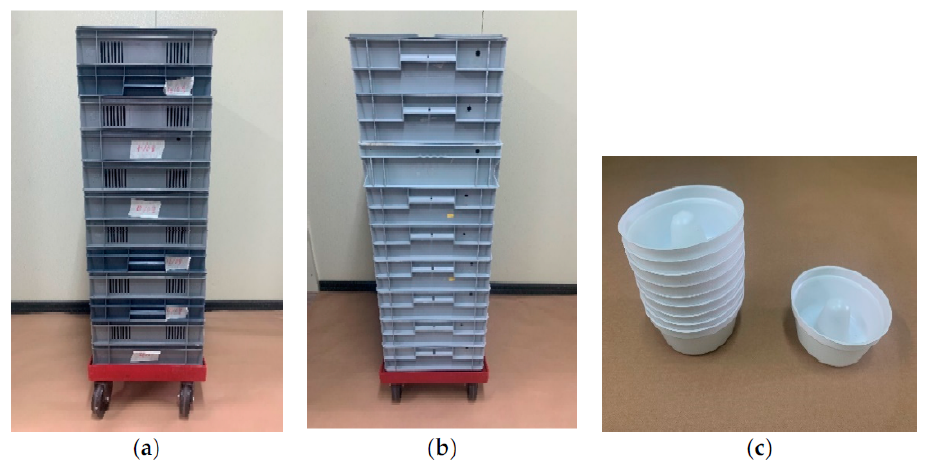
Figure 2. ( a ) Egg maturation trays. ( b ) Larval rearing trays. ( c ) Irradiation